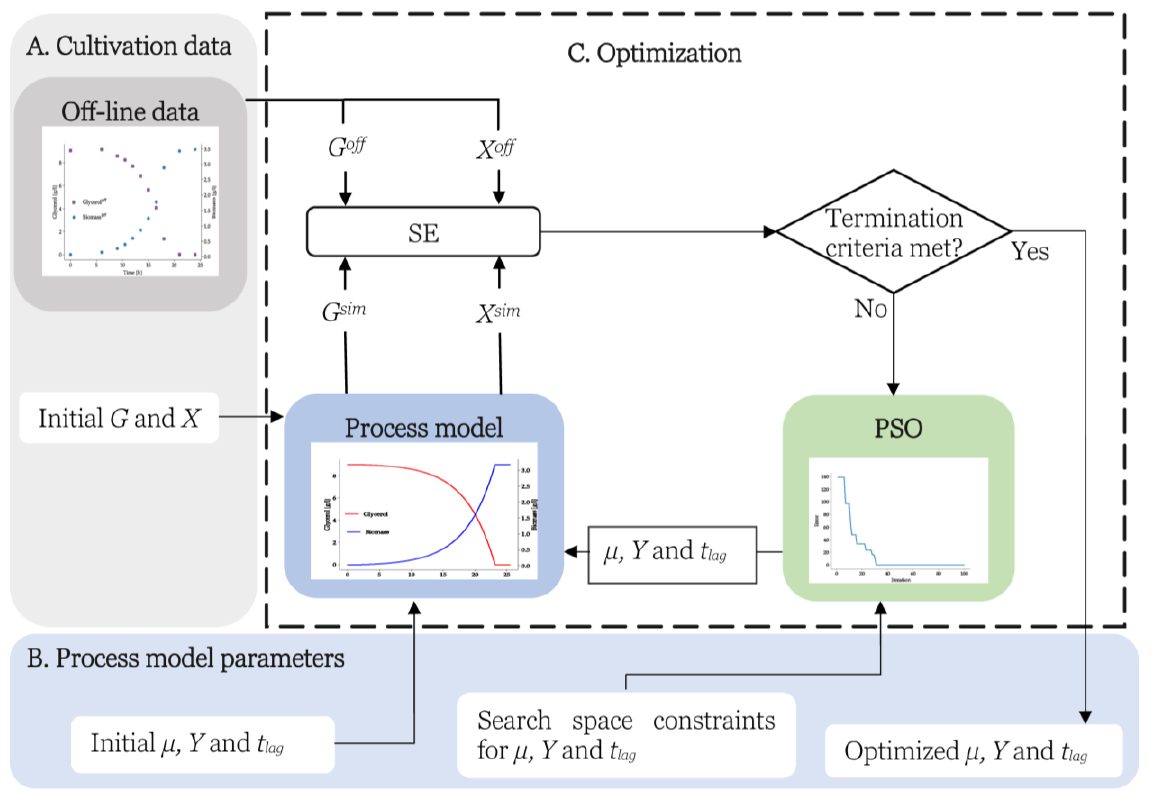
Figure 1. Classical least-squares approach to optimize the mathematical process model parameters for batch cultivation of H. polymorpha using offline data. The following are represented by different symbols: µ for the growth rate, Y for the yield factor, t lag for the lag time, G and X for the concentra- tions of glycerol and biomass; G sim , X sim for simulated concentrations of glycerol and biomass; and G off and X off for offline measurements of glycerol and biomass, respectively, PSO is the particle swarm optimization algorithm. Section A displays the offline data acquired during cultivation, Section B shows the initial and optimized process model parameters, and Section C illustrates the optimization process. The objective of the optimization was to minimize the sum of error (SE). The embedded graphs do not represent actual results; they are used for visualization.